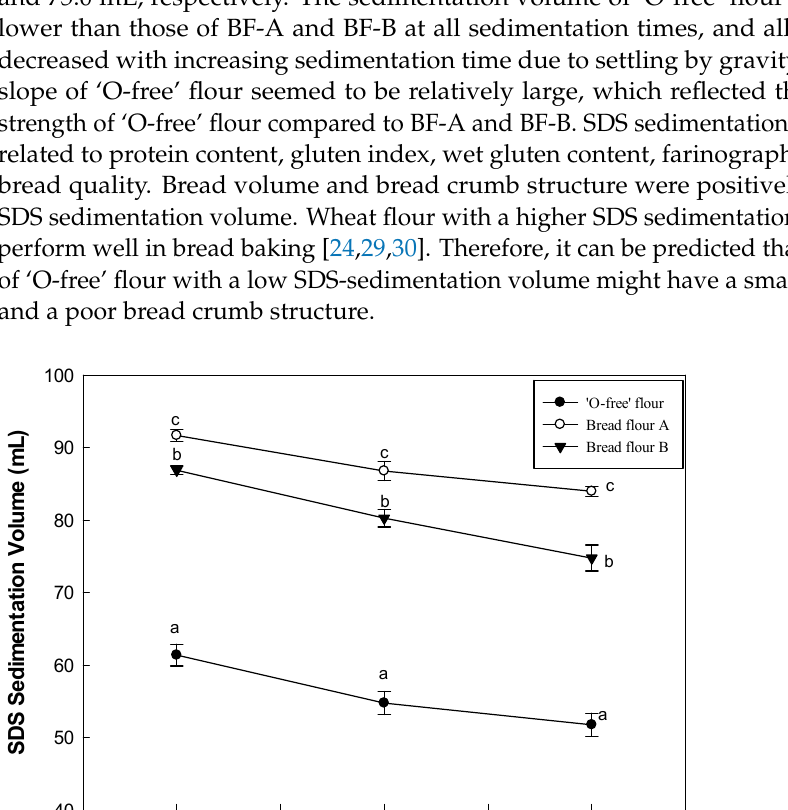
Figure 3. Mixograms of the flour samples: ( A ), ‘O ‐ free’ flour; ( B ), Bread flour A; ( C ), Bread flour B. 3.4. Quality Characteristics of Bread Prepared with Flours Figure 4 shows the photos of bread prepared with ‘O ‐ free’ flour. The height and vol ‐ ume of the bread made of ‘O ‐ free’ flour were significantly smaller than those of BF ‐ A and BF ‐ B. A strong correlation has been reported between protein content and bread volume of wheat flour: bread volume increases with the increased protein content of the flour, and